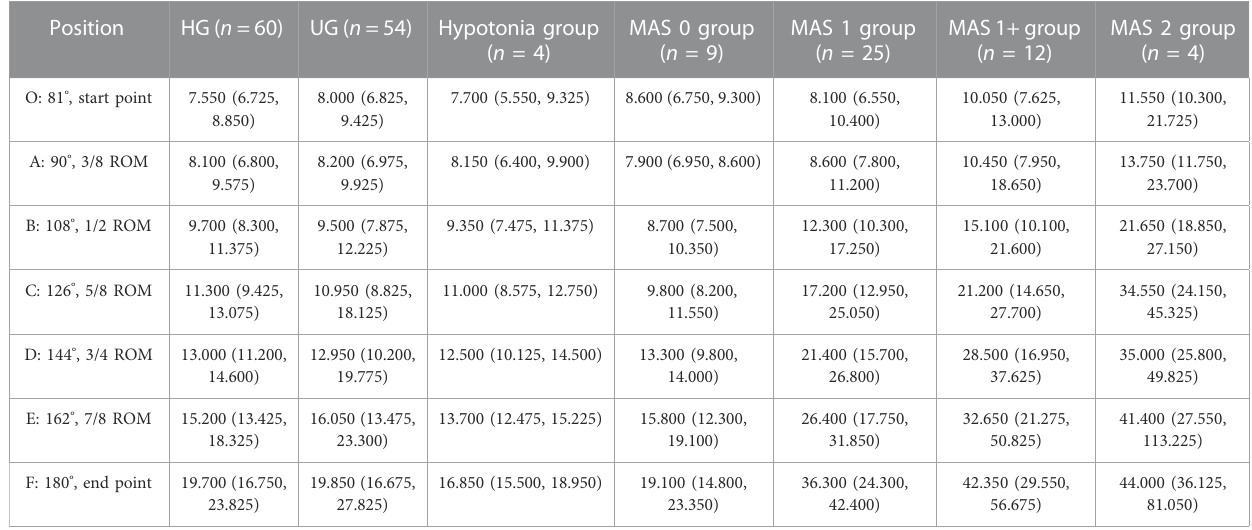
TABLE 2 Young ’ s modulus value of each position in each group.